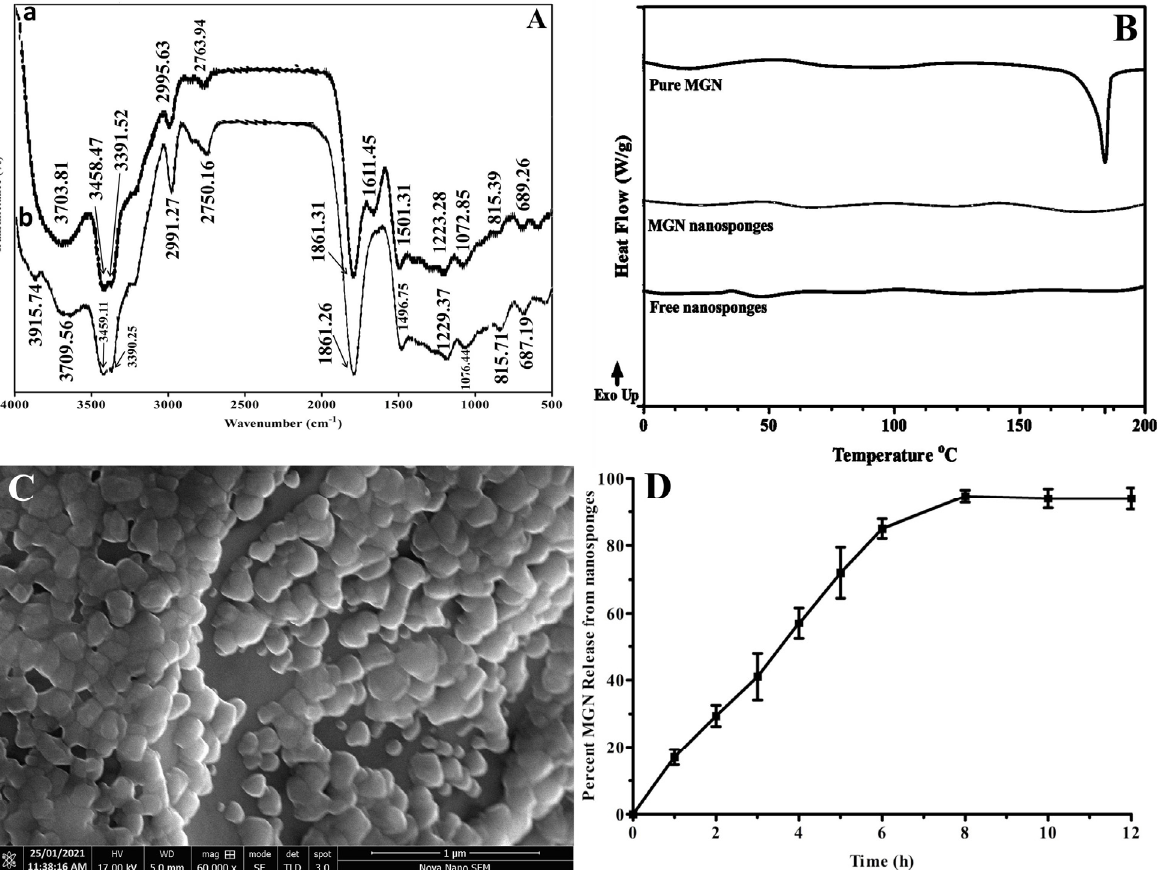
Figure 2. Physico-chemical characterization of prepared MGN nanosponges concerning FTIR ( A ) where spectrum (a) represents pure MGN while (b) shows MGN nanosponges, DSC ( B ), scanning electron microscopy ( C ), and MGN release from nanosponges ( D ).